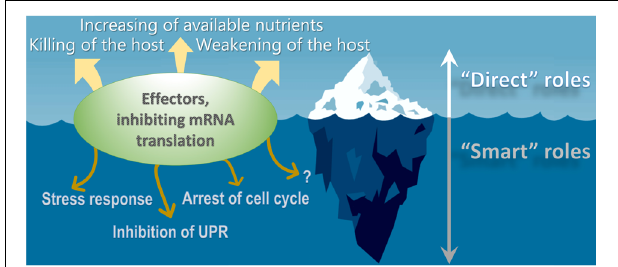
FIGURE 2 | Different roles of Legionella effectors inhibiting eukaryotic mRNA translation. The bacterial inhibitors of eukaryotic protein synthesis may facilitate decrease in the translation of eukaryotic transcripts thus providing a large pool of unused nutrients to Legionella , weakening of antibacterial activity and ultimately – killing of the host. The above examples represent “direct” roles of the effectors. However, the latter proteins might also play “smart” roles in the virulence of Legionella that are aimed at delicately manipulating host cell functioning for the benefit of the pathogen, including regulation of stress response, suppressing of unfolded protein response, arrest of cell cycle progression and possibly some other processes, which are unknown to date.